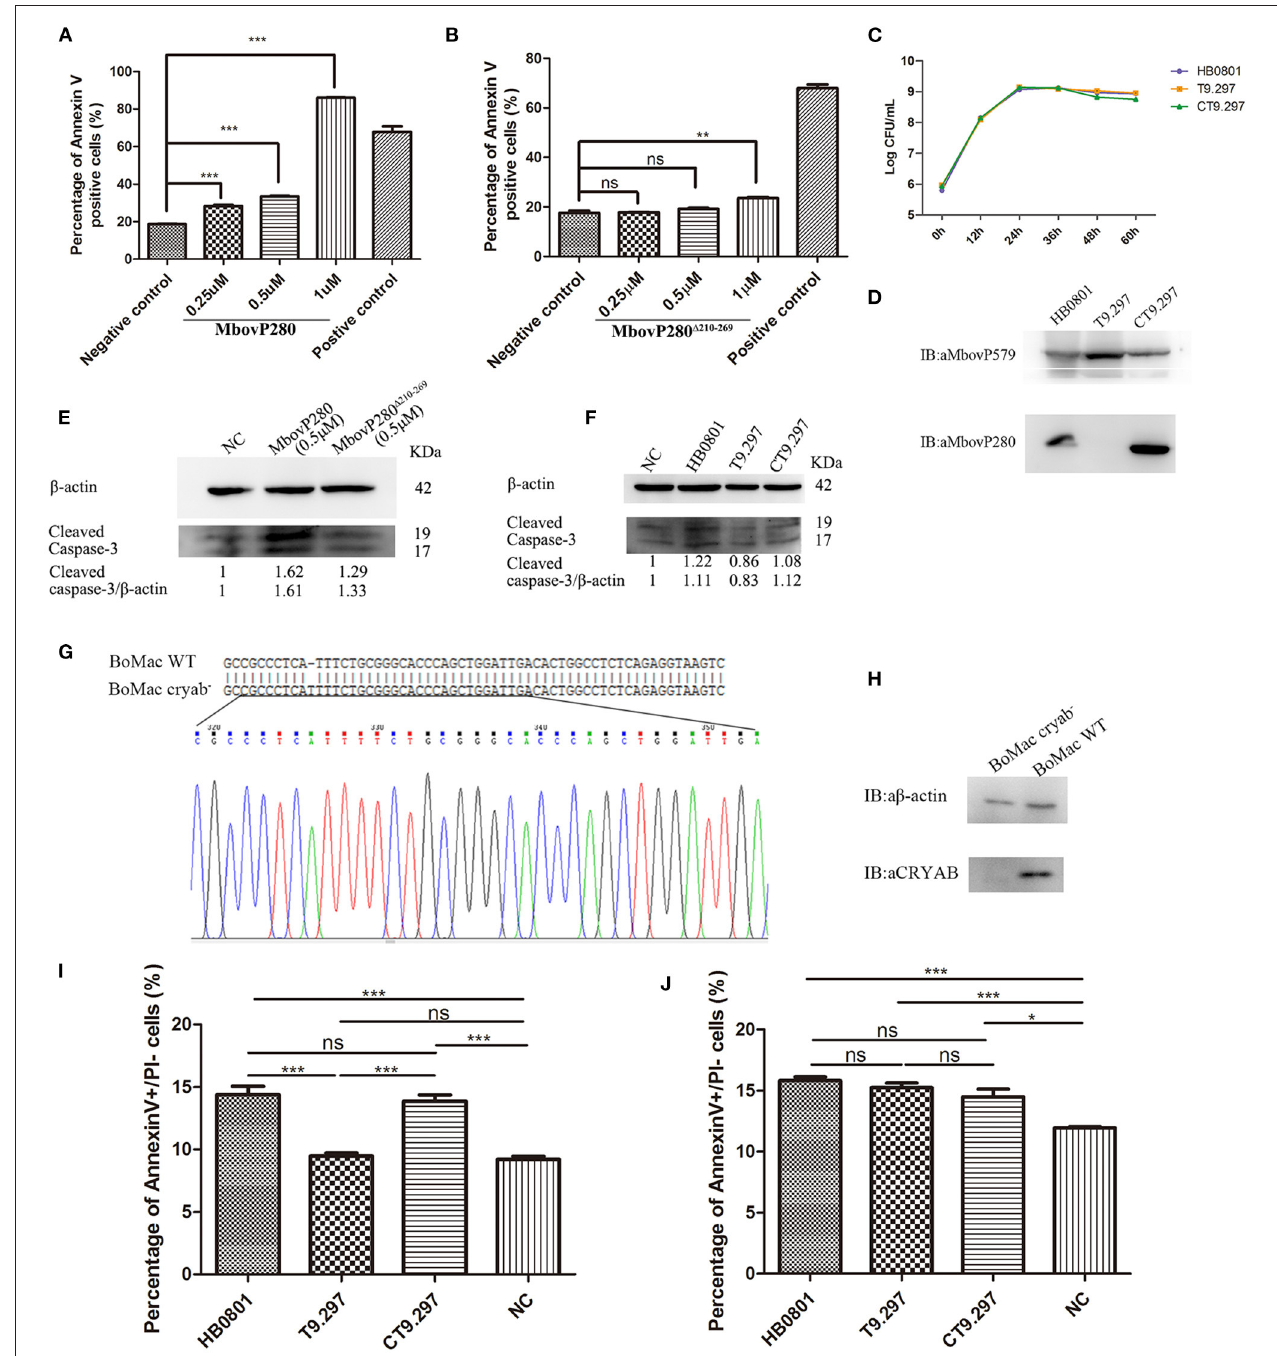
FIGURE 3 | Apoptosis of BoMac cells induced by MbovP280 in mycoplasmas cells or as the recombinant protein. Cells (5 × 10 5 per well) were treated with MbovP280 (A) or MbovP280 1 210 − 269 (B) at concentrations of 0.25, 0.5, or 1 µ M for 24h. The cells were then stained with annexin V and propidium iodide (PI) and detected with flow cytometry. (C) Growth curves of strains HB0801, the Mbov_0280 mutant T9.297, and its complement CT9.297. Growth of M. bovis at each time point was determined with a plating assay. (D) Visualization of MbovP280 expression in T9.297 and CT9.297 strains with a western blotting assay. Wild-type strain HB0801 was used as the positive control. (E) The cleaved caspase-3 of BoMac cells treated with rMbovP280. The cell lysates of BoMac treated with 0.5 µ M rMbovP280 or rMbovP280 1 210 − 269 were resolved with SDS-PAGE, transferred onto membrane, and then immunodetected with an antibody directed against cleaved caspase-3. β -actin was used as the internal control. The ratio of the amount of cleaved caspase-3 to the amount of β -actin was calculated and normalized to the NC. (F) The cleaved caspase-3 of BoMac cells infected with M. bovis . The cell lysates of BoMac infected with HB0801, T9.297, or CT9.297 (MOI = 1,000) were